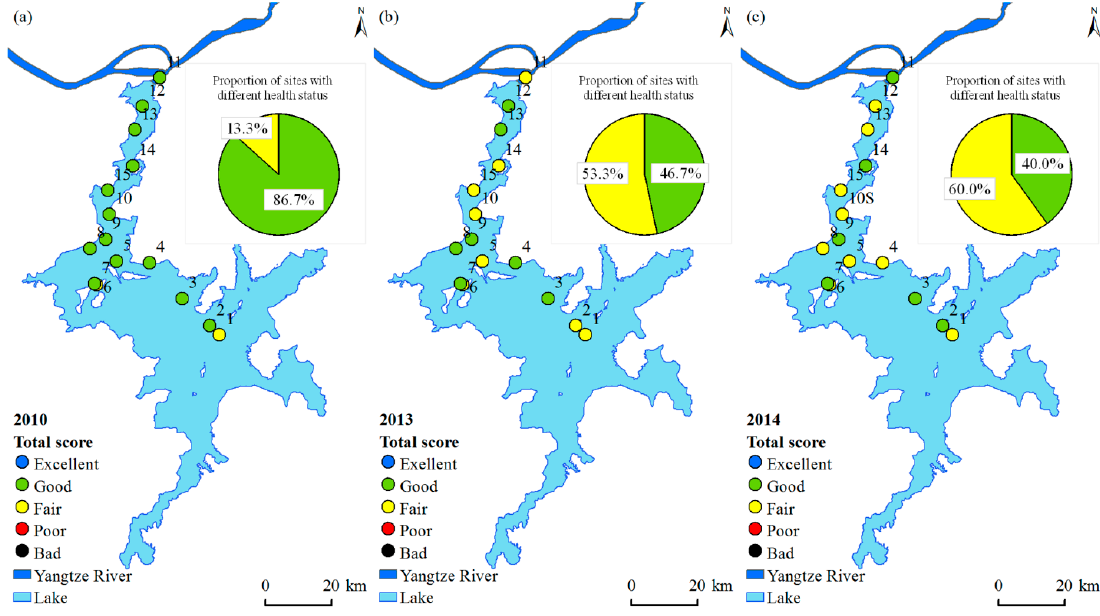
Figure 2. Total score of health status at the sample sites in Lake Poyang in 2010 ( a ), 2013 ( b ) and 2014 ( c ).